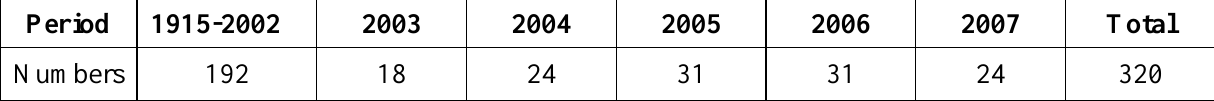
Table 1 . Numbers of references published recent years.